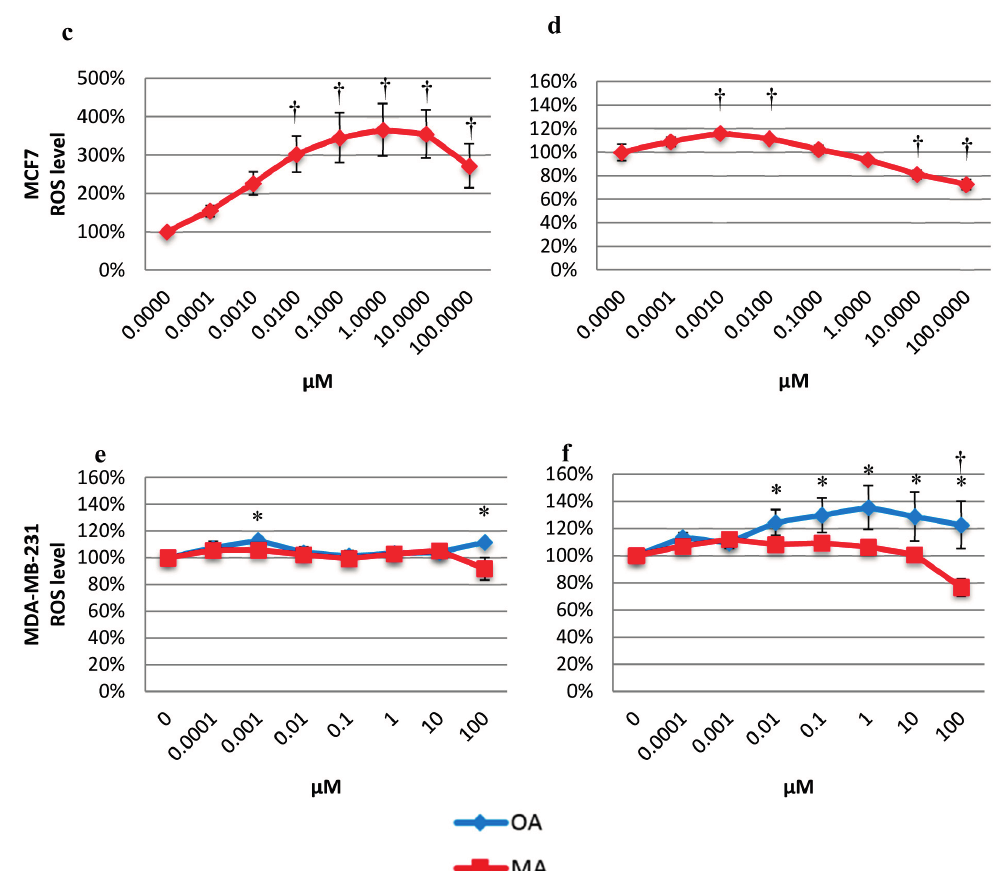
Figure 5. The ROS levels present in MCF10A cells in the basal state ( a ) and with H 2 O 2 burst ( b ); in MCF7 cells in the basal state ( c ) and with H 2 O 2 burst ( d ); and in MDA-MB-231 cells in the basal state ( e ) and with H 2 O 2 burst ( f ) after treatment with OA or MA from 0.0001 µM to 100 µM for 4 h. Values represent the mean ± SEM of three independent experiments. Statistically significant differences are represented by (*) for OA and (†) for MA at p < 0.05 with respect to the untreated